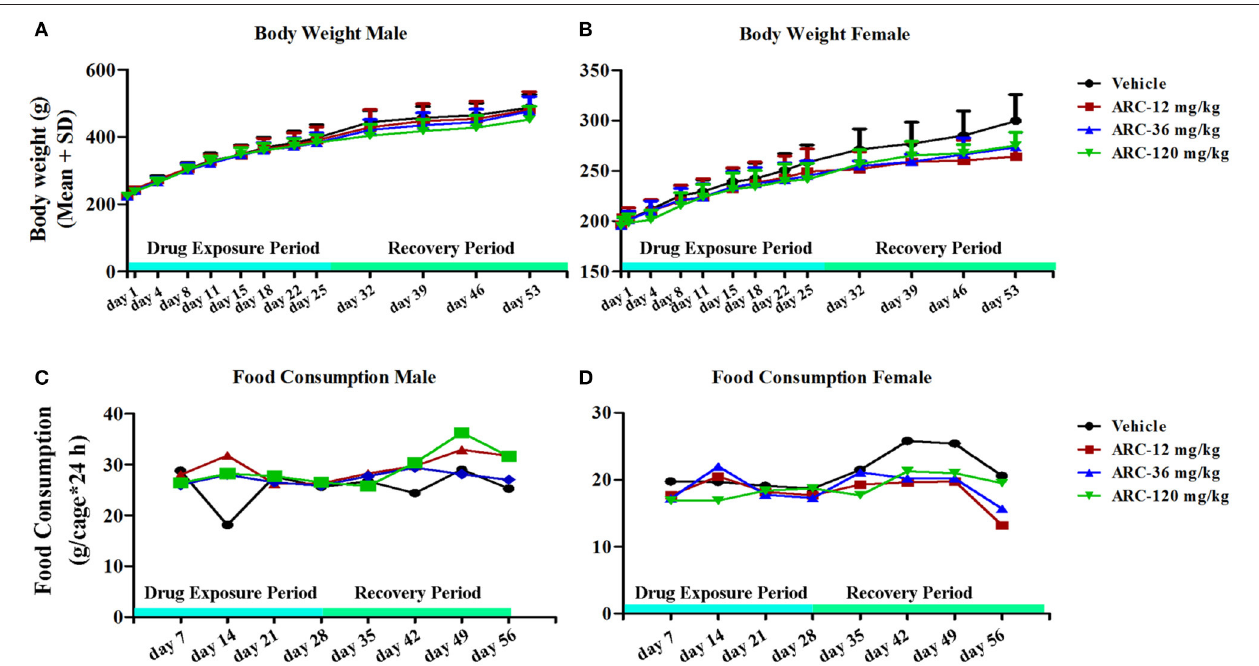
FIGURE 1 | Body weight and food consumption of rats treated with Arctigenin at sub-chronic toxicity levels. (A) Body weight of males. (B) Body weight of females. (C) Food consumption of males. (D) Food consumption of females. ( n = 10 or 5 per treatment group; results are presented as the mean +